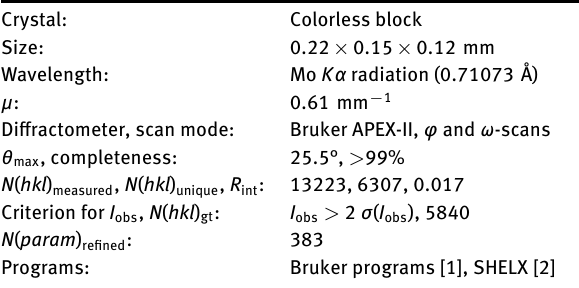
Table 1: Data collection and